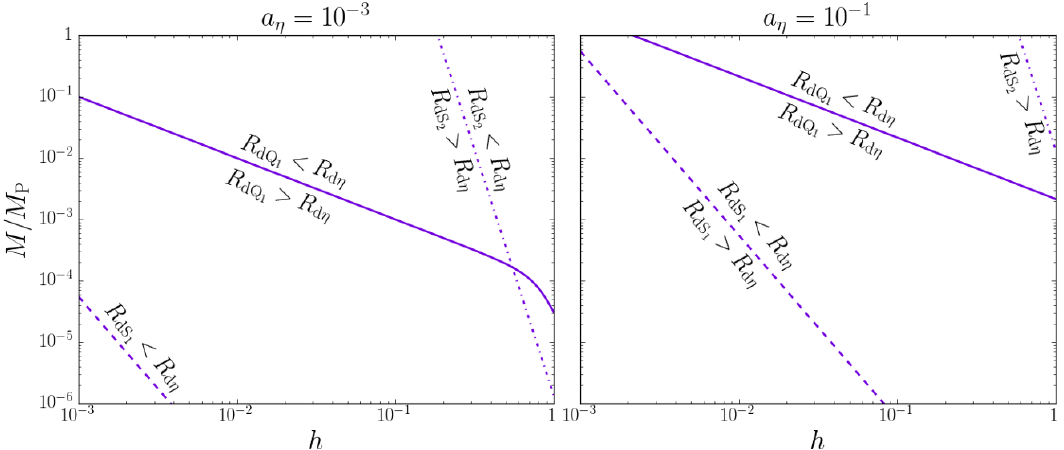
Figure 1 . The curves of (cid:0) i = (cid:0) (cid:17) , where i = Q 1 ; S 1 ; S 2 , for small (large) coupling a (cid:17) = 10 (cid:0) 3 (cid:30) ISS ( a (cid:17) = 10 (cid:0) 1 ). Above the curves, their decay rates (cid:0) i become larger, implying a smaller scale (cid:30) ISS factor at the time of their